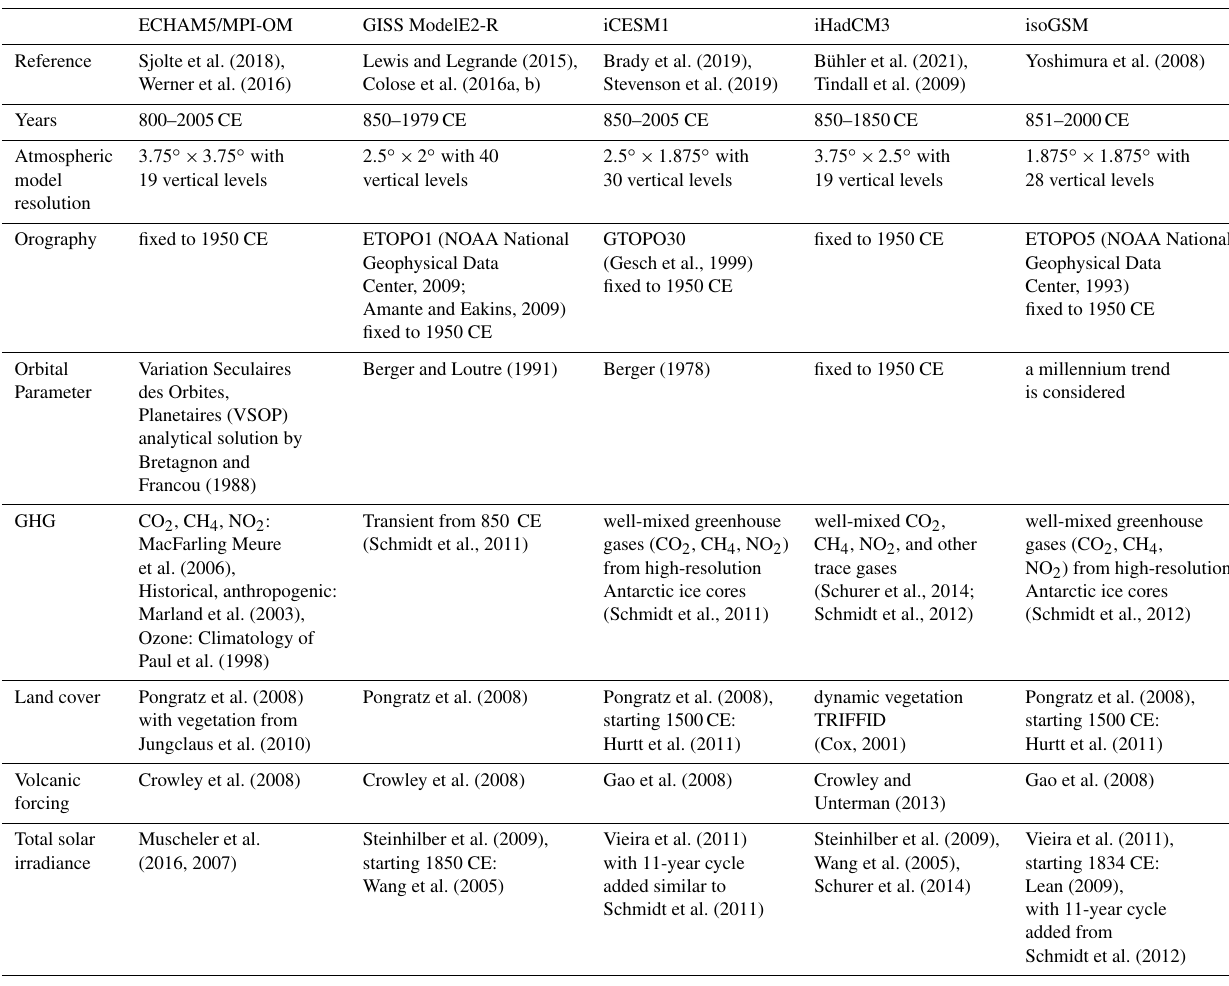
Table 1. Basic characterization of the last millennium